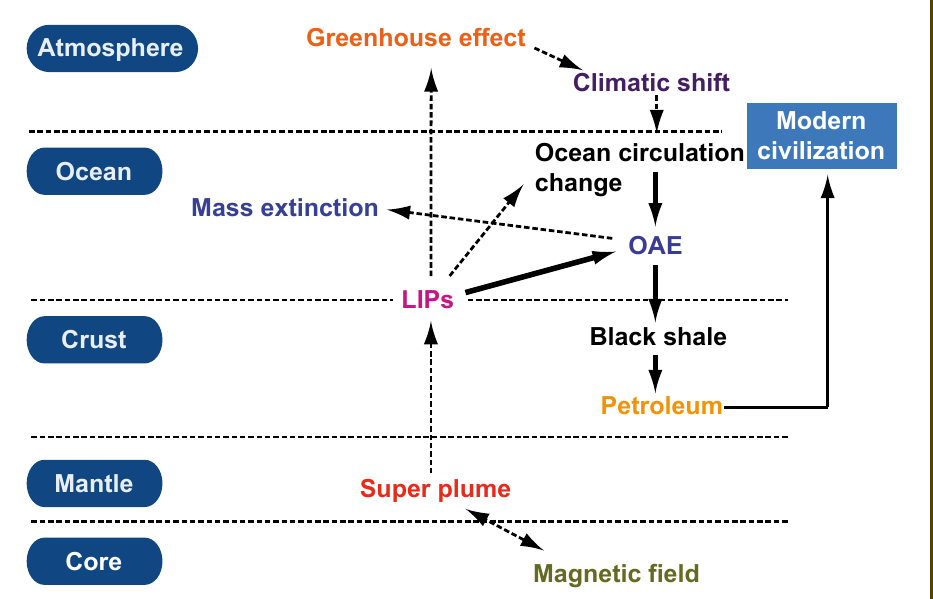
Figure 6. Proposed interconnections between reservoirs and fluxes within the Earth system during extreme volcanic events (Naohiko Ohkouchi, personal communication during INVEST meeting). The emplacement of large igneous provinces (LIPs), an expression of the Earth's interior behavior, could explain episodes of enhanced greenhouse gas input to the atmosphere and subsequent climatic and ocean circulation changes that lead to Oceanic Anoxic Events (OAEs). OAEs are extreme oceanic events marked by enhanced organic carbon burial and related biological